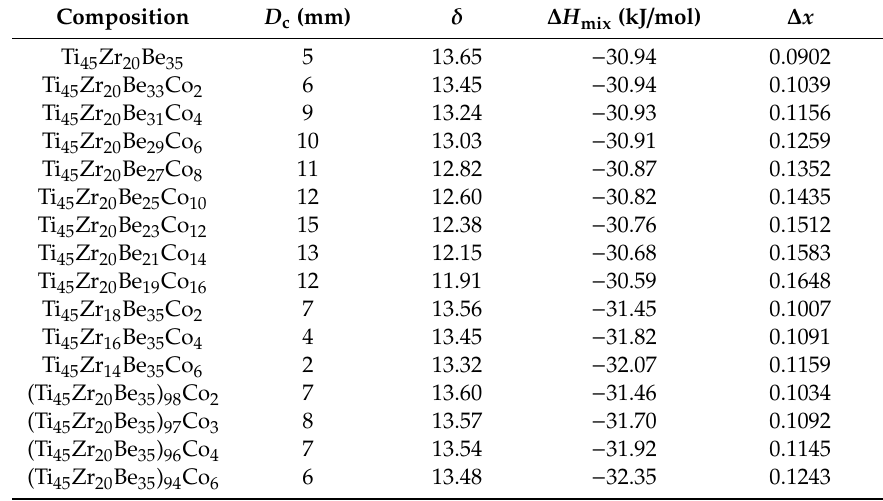
Table 2. The variation of parameters including ∆ H mix , δ , and ∆ x induced by Co alloying together with D c